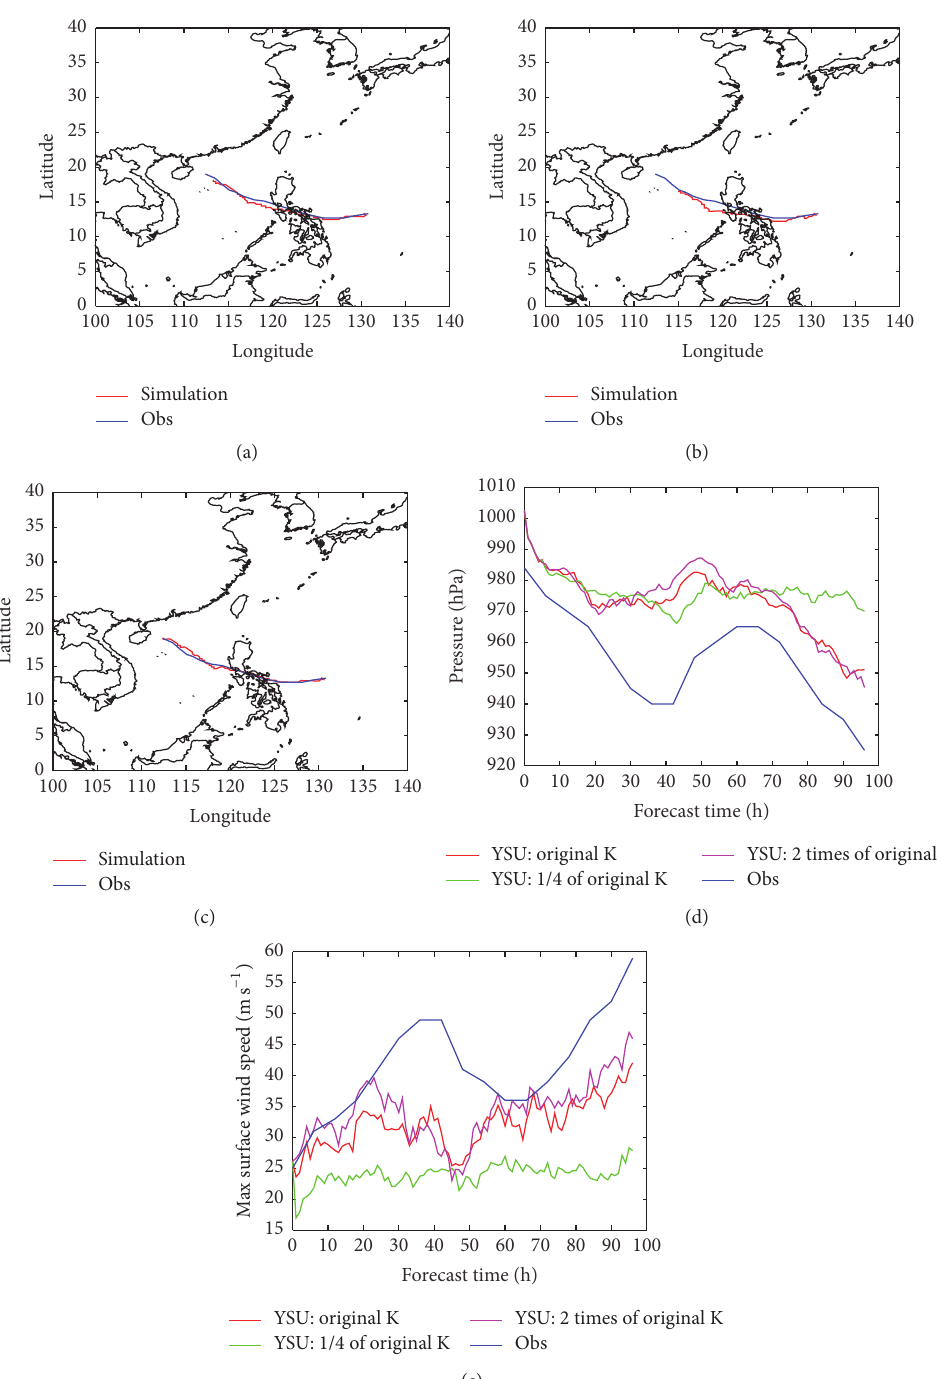
Figure 3: Case 2-Rammasun: (a) track simulated by the original YSU; (b) track simulated by the K025; (c) track simulated by the K200; (d) comparisons of center sea-level pressure; and (e) comparisons of maximum surface wind